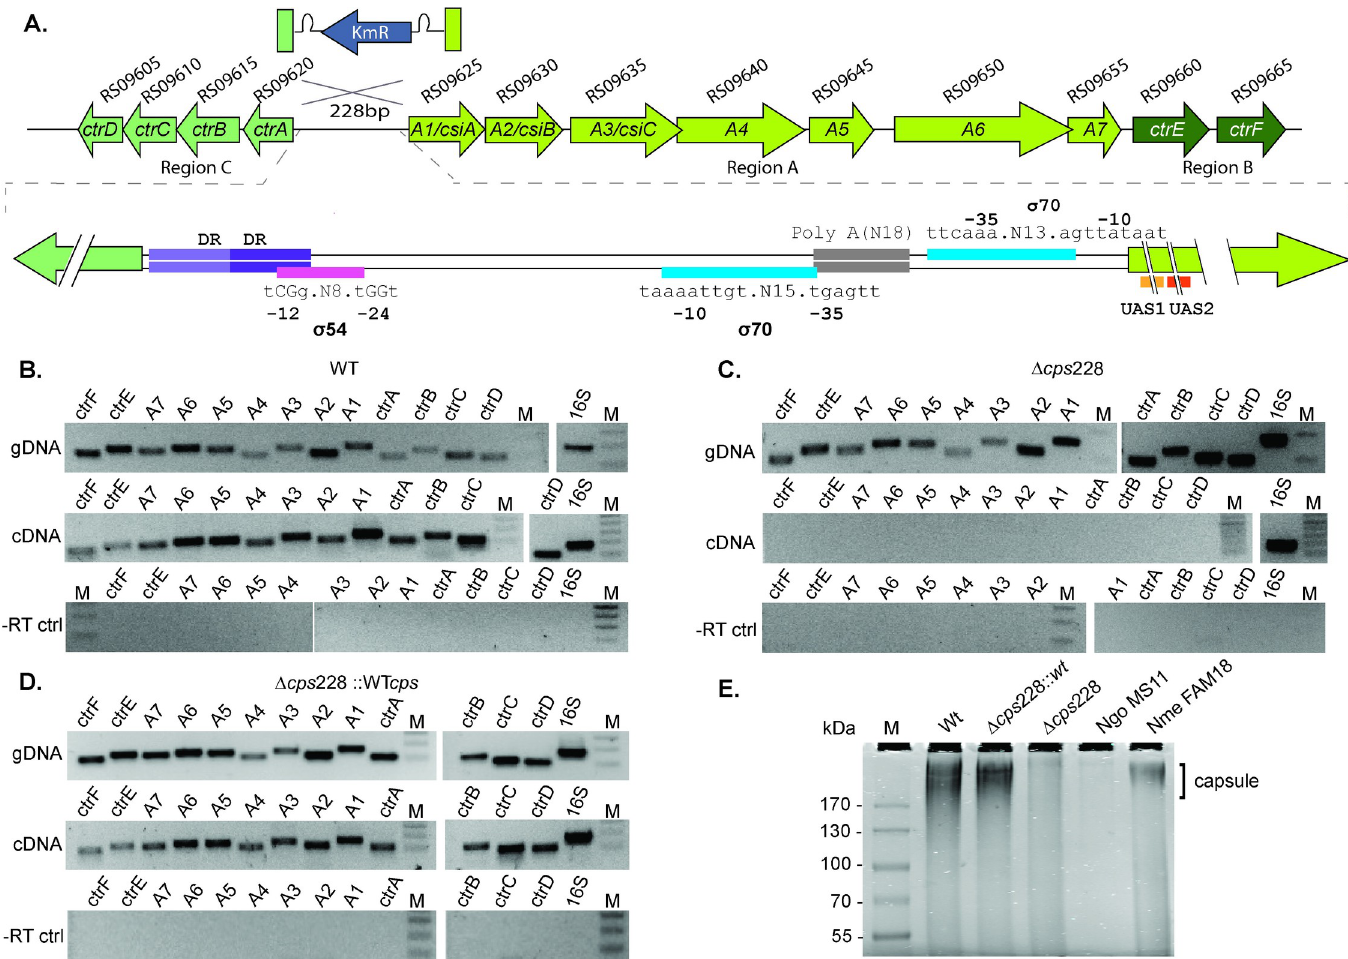
Fig 6. N . musculi mutants with a deletion of the capsule cluster regulatory region are unencapsulated. Validation of the candidate genes implicated in capsule biosynthesis and transport. A. Arrangement of the N . musculi capsule biosynthesis and transport genes. Shaded boxes indicate Neisseria genus capsule locus. Genes in Region C (transport), Region A (biosynthesis) and Region B (translocation) are given the name of the closest N . meningitidis homolog or functional analog, and the N . musculi GenBank refseq locus tag. Orange lines indicate the position of the upstream activator sequences (UAS1, tgtttttttgcacggcaca, and UAS2, tgtcaatgtcagagcact) in csiA/ A1. The sequence of the 228 bp intergenic region between ctr A and A1 is highlighted by a dashed line. Sigma 70 binding sites are highlighted by a blue line, and Sigma 54 binding site is indicated by the pink line. The 17 bp direct repeat (DR, acaaatagccaaaaaca) is marked by a purple line. The grey line shows the location of the poly A tract. To test the hypothesis that the intergenic region between A1 and ctrA control capsulation, the 228 bp segment of DNA was replaced with a Kanamycin cassette (blue arrow). B-D. Deletion of the capsule locus intergenic region ablates transcription of all capsule biosynthetic and transport genes. cDNA was generated from Wt (B), cps mutant (C) and the complemented strain (D), and primers specific to each gene were used to amplify transcript co-transcribed from the promoter located in the 228 bp intergenic region. No difference was observed in Wt or Δ cps228 ::Wt strains in comparison to genomic DNA controls and -RT controls. E. Loss of the capsule locus intergenic region results in loss of capsule production. SDS PAGE gel of capsule extracts isolated from N . musculi Wt, capsule mutant and complemented strains, compared to the N . gonorrhoeae MS11 and N . meningitidis FAM18 negative and positive controls, respectively. Alcian blue staining shows a reduction in polysaccharide content between the Wt and capsule deletion mutant extracts. M, molecular weight